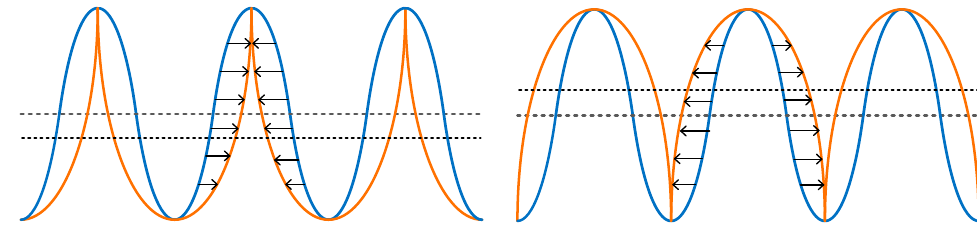
Figure 2. Conceptual illustration of velocity bunching. The blue curve is the ‘real’ monochromatic wave height, the orange curve is the effect of velocity bunching. The gray dash line is the original mean sea surface height (SSH), the black dash line is the mean SSH with velocity bunching.